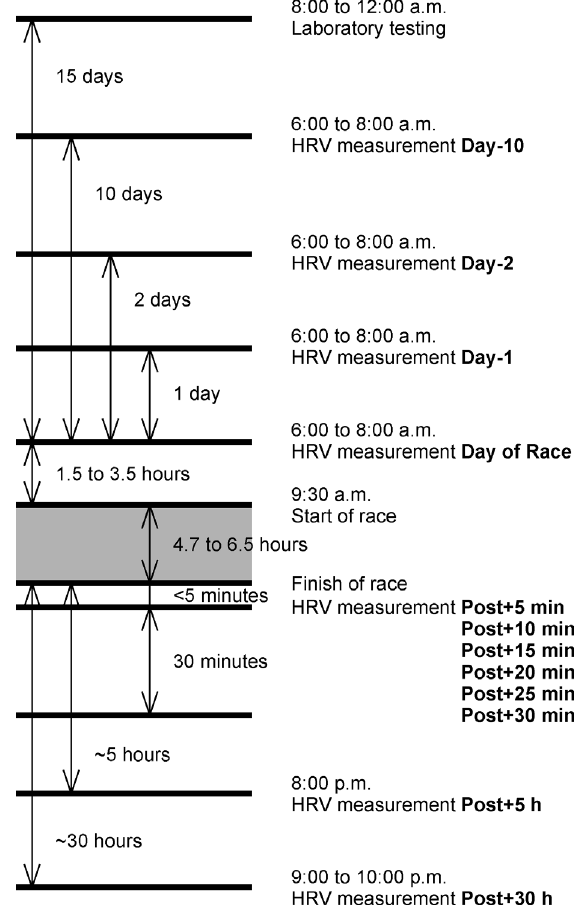
Figure 1. Overview of the study design and depiction of HRV measurements. The time axis is not propor- tional with time values to capture large differences in time